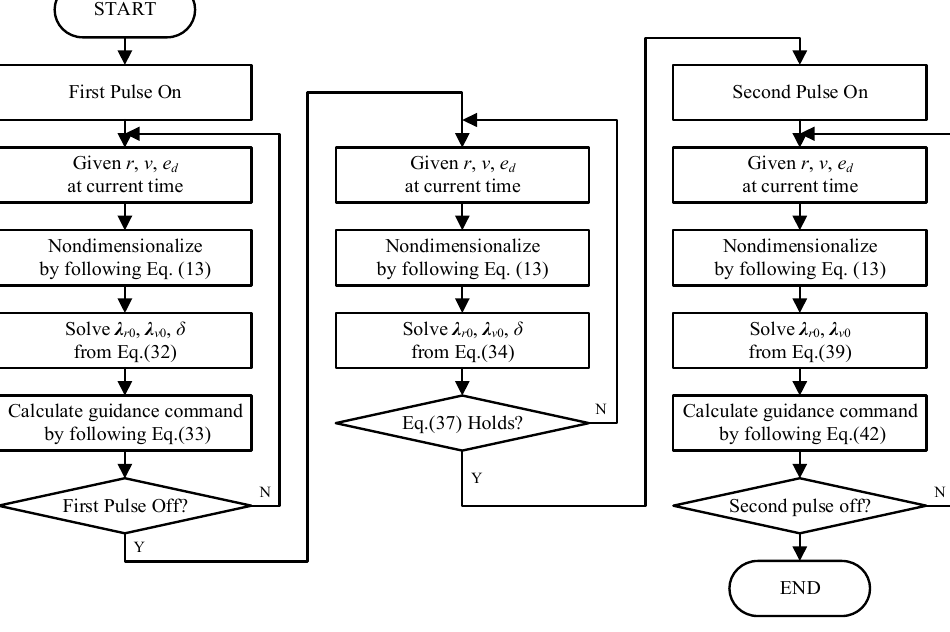
Figure 1. The complete IGM procedure.